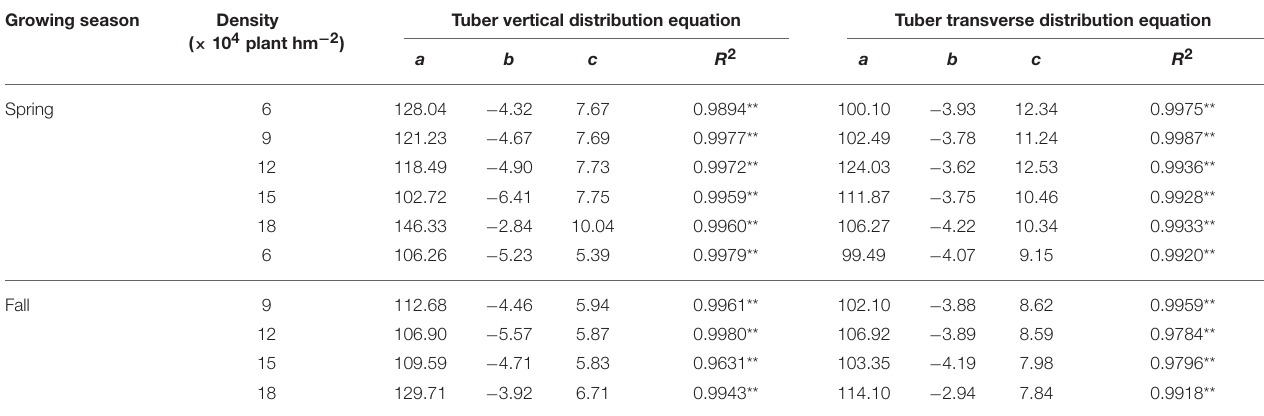
TABLE 6 | Cumulative percentage equation parameter values associated with potato tuber number and equations used to determine coefficients ( R 2 ) under different plant densities. Growing season